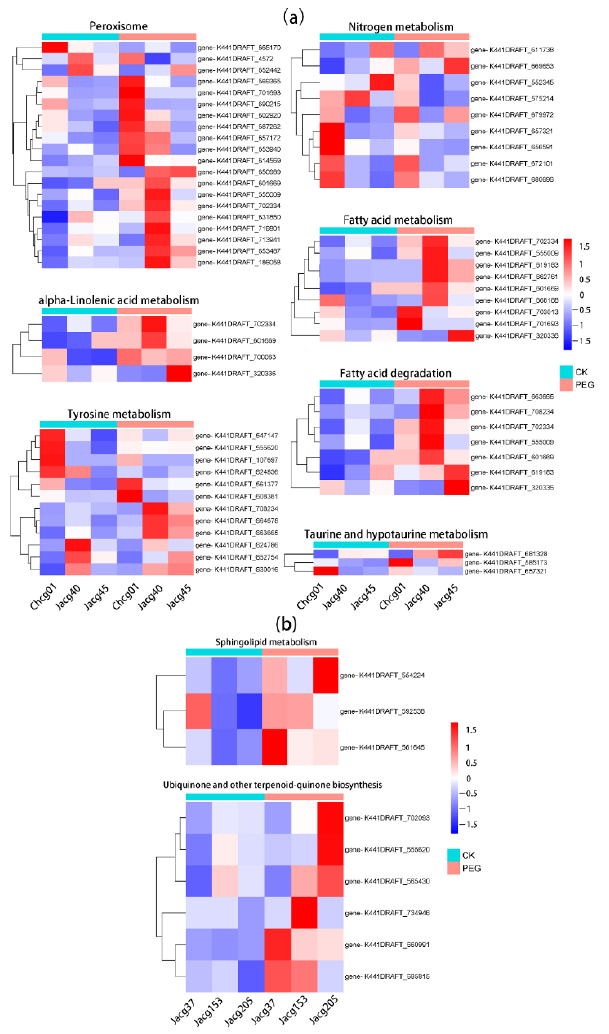
Figure 8. The heatmap of DEGs in the different pathways in six strains of Cenococcum geophilum after 0% and 10% PEG-6000 treatments. ( a ), sensitive strains; ( b ), tolerant strains. The Y- and X-axes